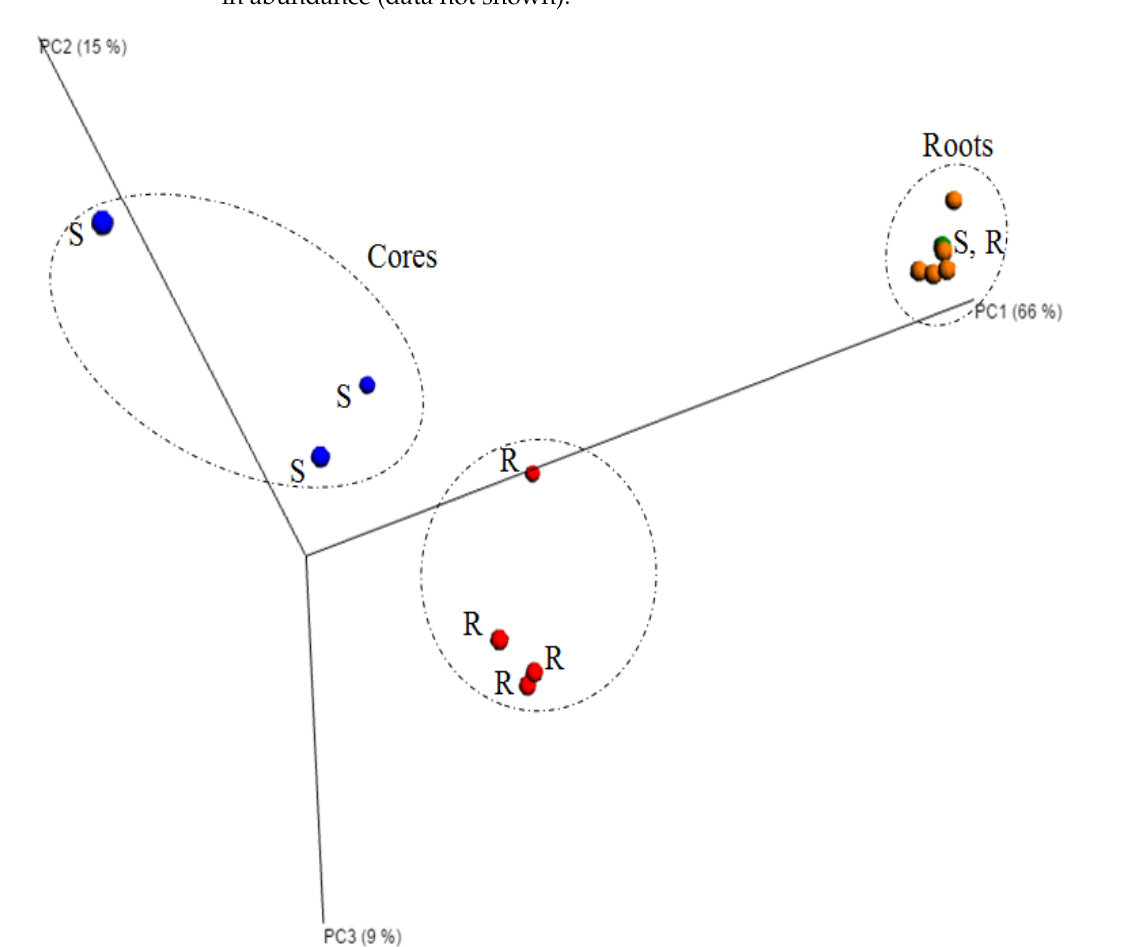
Figure 5. Principal Ccoordinates Analysis (PCoA) of bacterial community sequences based on 16S rRNA amplicons from hyphosphere cores (red (static, S) and blue (rotating, R)) and rhizosphere roots (green (static, S) and orange (rotating, R)) of Agrostis stolonifera . Static = mycorrhizal and rotating = severed mycorrhizal hyphae treatments. PCoA was calculated using an un-weighted Unifrac distance matrix and visualised with EMPeror.